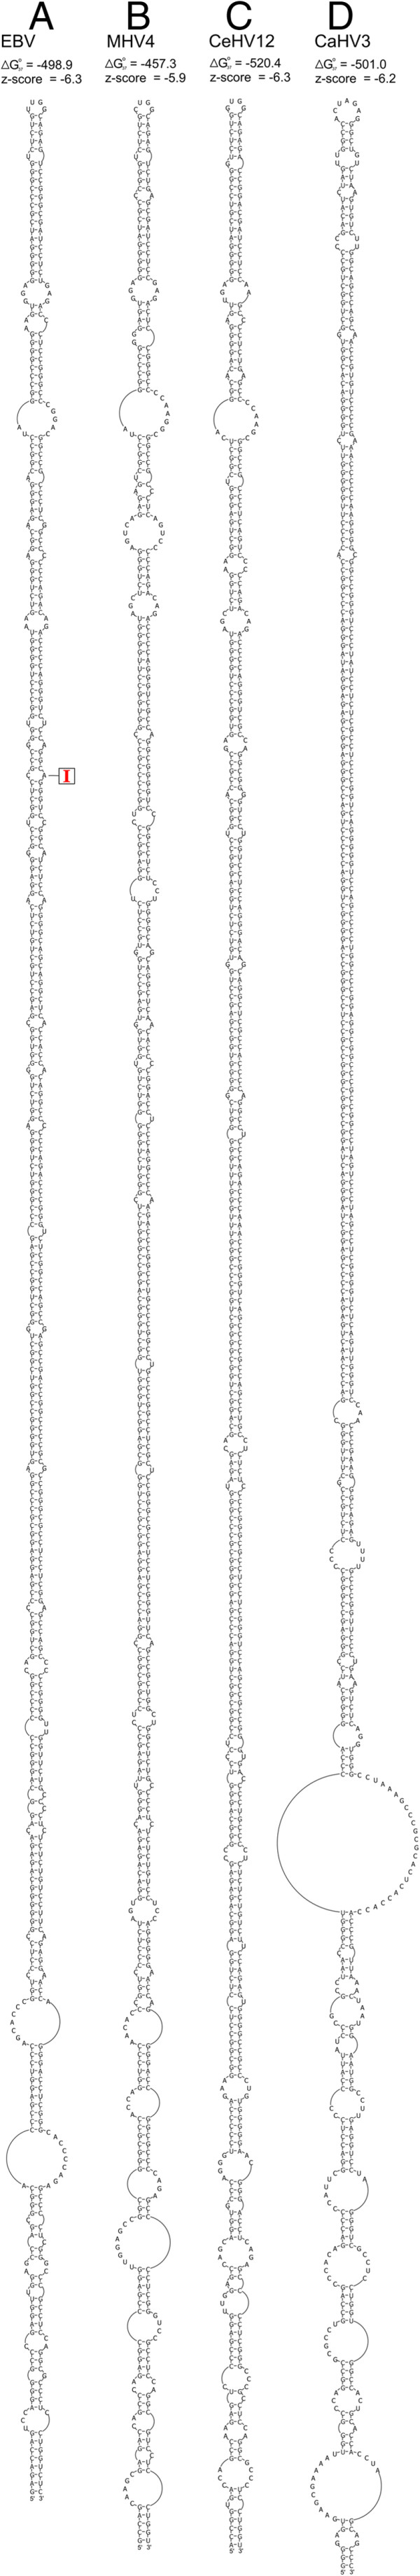
Structure models for lymphocryptovirus repeat long hairpin RNAs. A reported A-to-I editing site [66] is indicated with a red “I”. Shown are sequences from (A) Epstein-Barr virus (EBV), (B) Macacine herpesvirus 4 (MHV4), (C) Cercopithecine herpesvirus 12 (CeHV12), and (D) Callitrichine herpesvirus 3 (CaHV3).